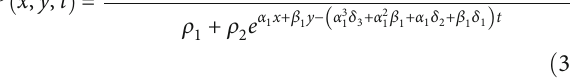
= 2, y = 10, and z = 2 2